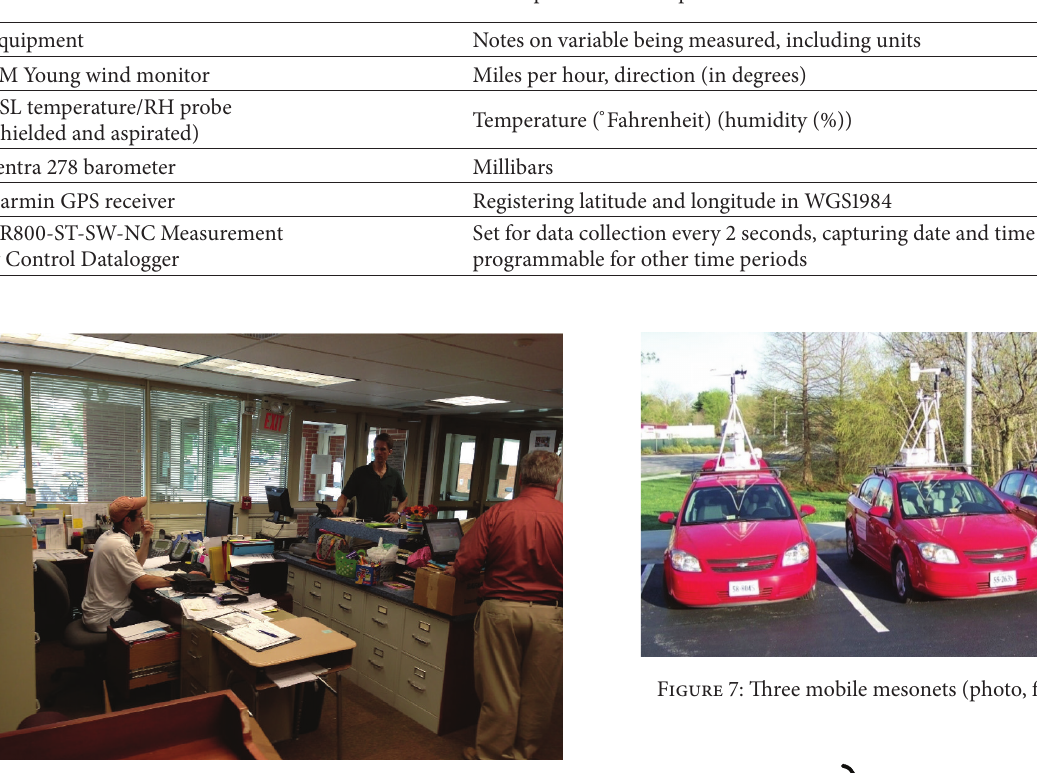
Figure 5: Paul Miller (Virginia Tech MS student), Tom Fitzpatrick (RCPS science coordinator), and Rob Moorefield, (RCPS IT special- ist) at Westside Elementary School (Photo, third author, 2013).